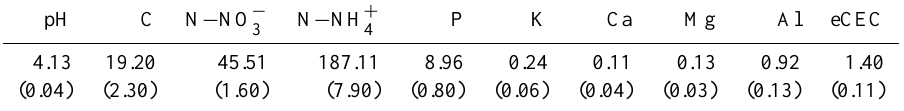
Table 1. Chemical characteristics of the soil used in this study (average of three replicates, with standard deviation in parentheses). pH C N − NO − N − NH + P K Ca Mg Al eCEC 3 4